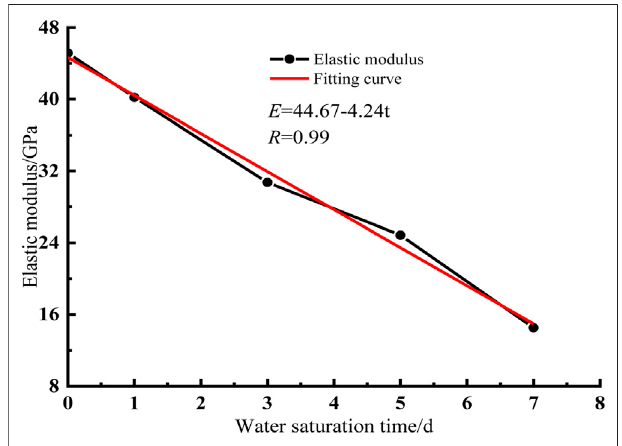
FIGURE3| Relationshipbetweenpeakstrengthofjointedlimestoneand water saturation time.